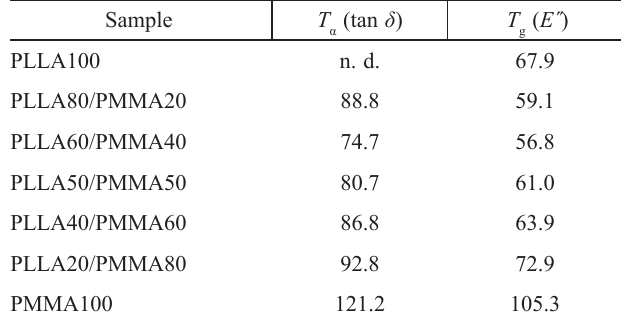
values from DMA measurements; loss factor